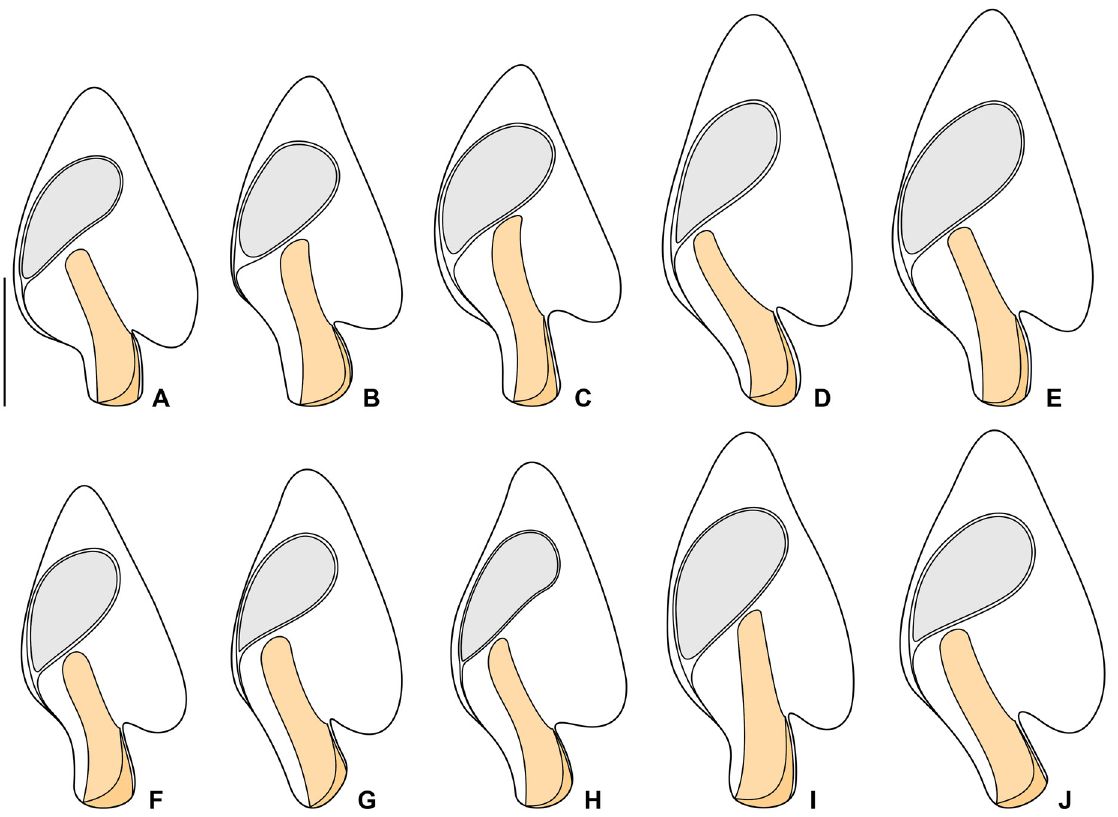
Fig. 10. Clevelandella parapanesthiae (Kidder, 1937). Vietnamese specimens isolated from Panesthia angustipennis cognata Bey-Bienko, 1969 after protargol impregnation. A–J . Variability of body shape and size as well as of the nuclear (shaded grey) and oral (shaded yellow) apparatus. Scale bar = 30